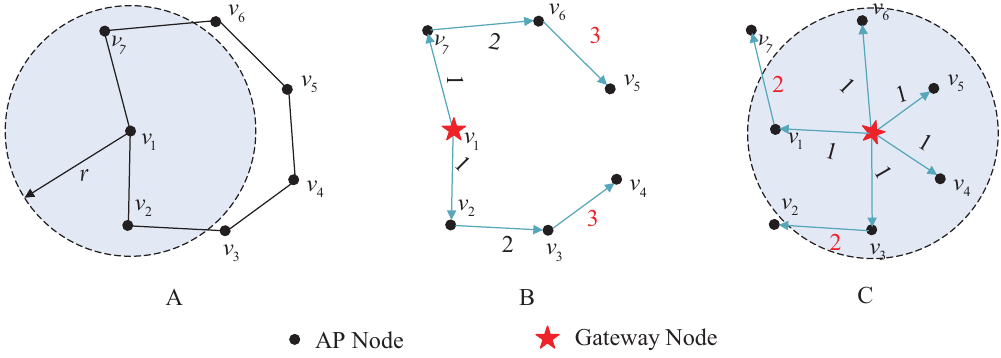
Figure 2. Gateway deployment of a 7-node network. ( A ) original network; ( B ) gateway deploying on node; ( C ) gateway deploying not on node.